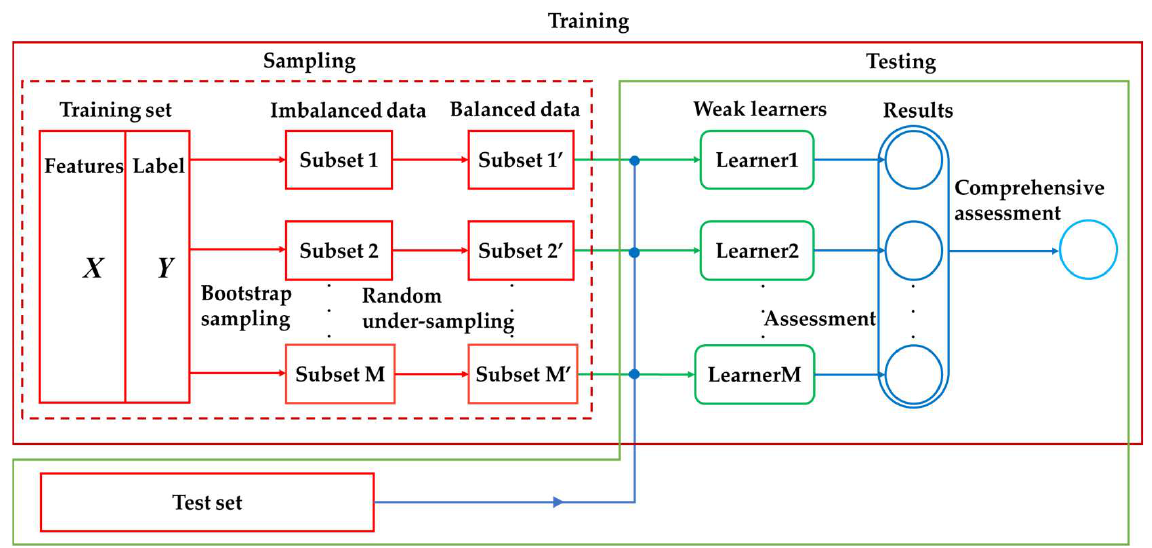
Figure 3. Schematic diagram of the random under-sampling bagging method.